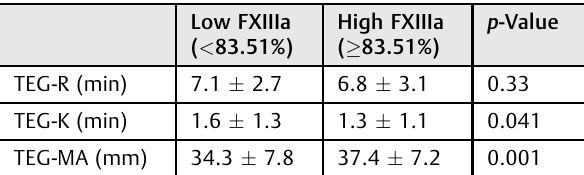
Table 2 Plasma TEG measures strati fi ed by low and high